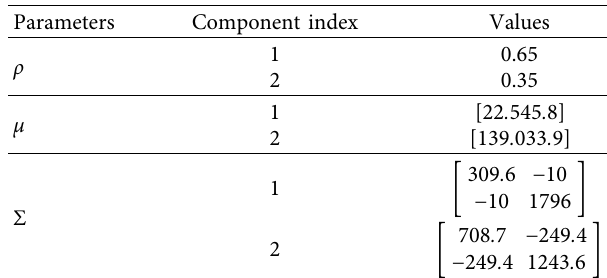
Table 4: GMM fitting